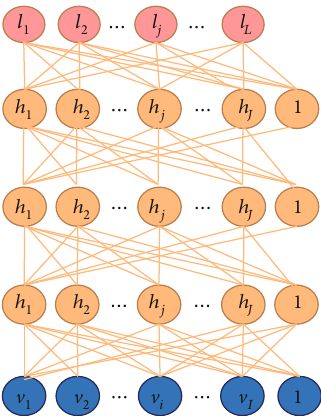
Figure 3: DBN/DNN